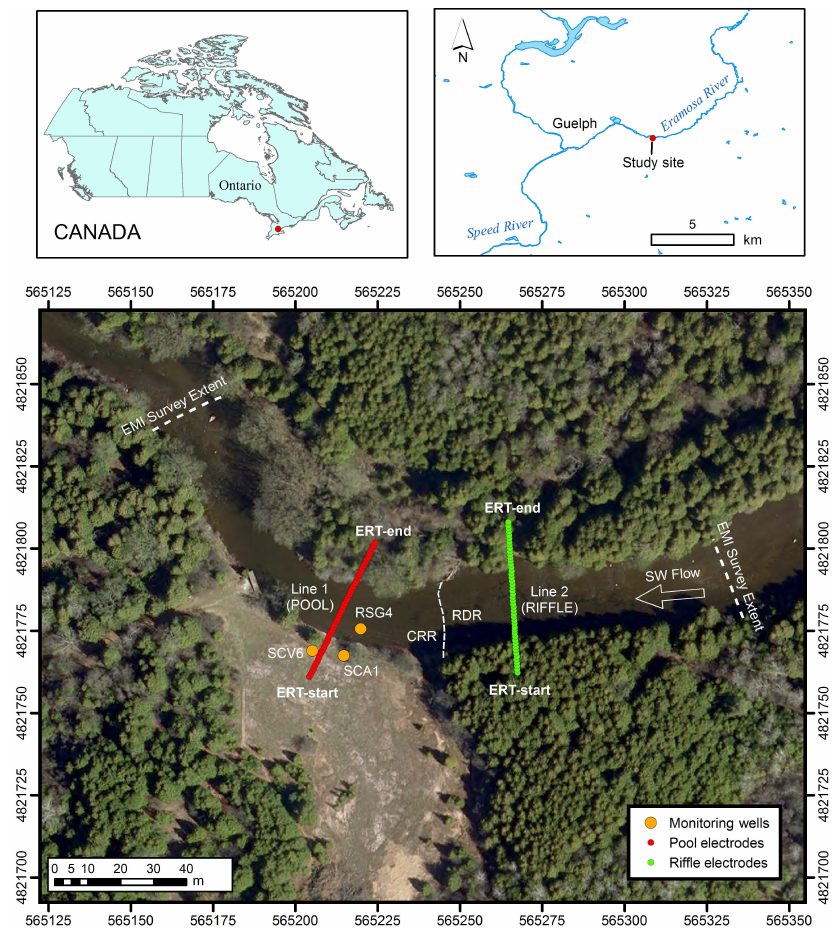
Figure 2. Field site located along the Eramosa River near Guelph, Ontario, Canada. The spatial extent of the electromagnetic induction (EMI) surveys, coreholes and groundwater–surface water monitoring points, and fixed electrical resistivity tomography (ERT) transects are shown relative to the riffle–pool sequence. The riverbed is described as either rubble-dominated riverbed (RDR) or competent rock riverbed (CRR)